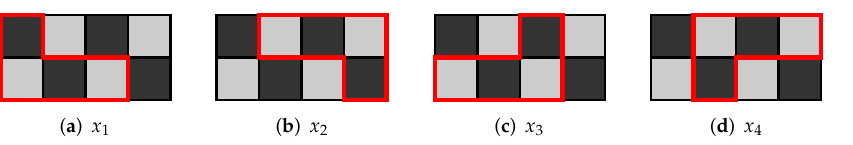
Figure 4. Possible placements of a coloured tetromino in R and the associated variables. The tetrominoes are outlined in